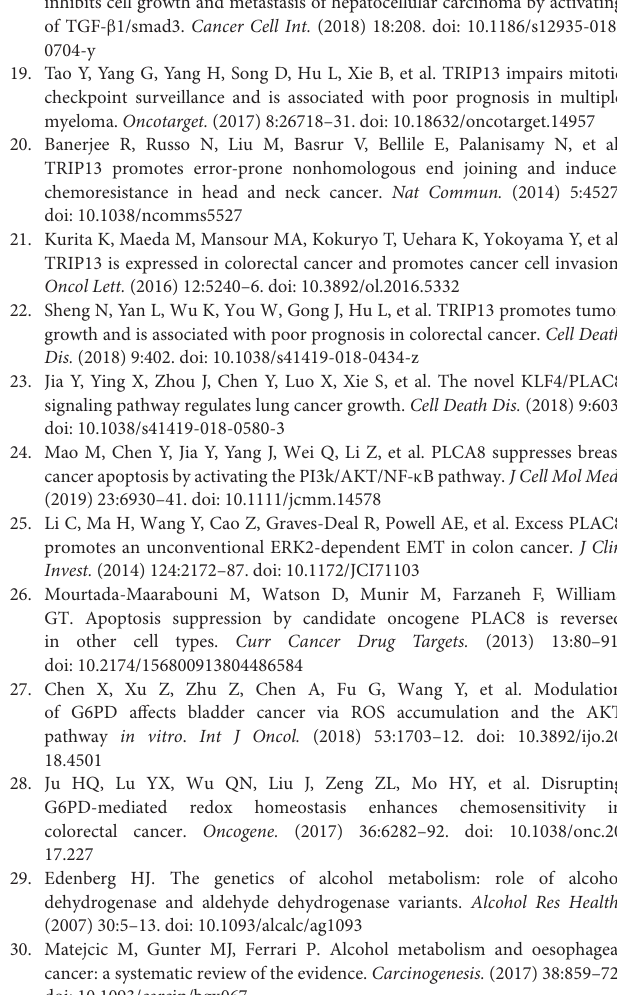
death, blue dots indicate alive) and the ROC curves for 1-, 2-, and 3-year survival in the in GSE15654 dataset; (C) The distribution of survival status (red dots indicate death, blue dots indicate alive) and the ROC curves for 1-, 2-, and 3-year survival in the in GSE14520 dataset. Figure S8 | GSEA analysis results in the high- and low-risk groups. Cell-Cycle and Wnt-signaling-pathway were highly expressed in the high-risk group. The Metabolism of Xenobiotics by Cytochrome P450 and the Primary Bile Acid Biosynthesis pathway showed low expression in the low-risk group. Table S1 | Metabolic pathways from Reactome database. Table S2 | Energy metabolism related